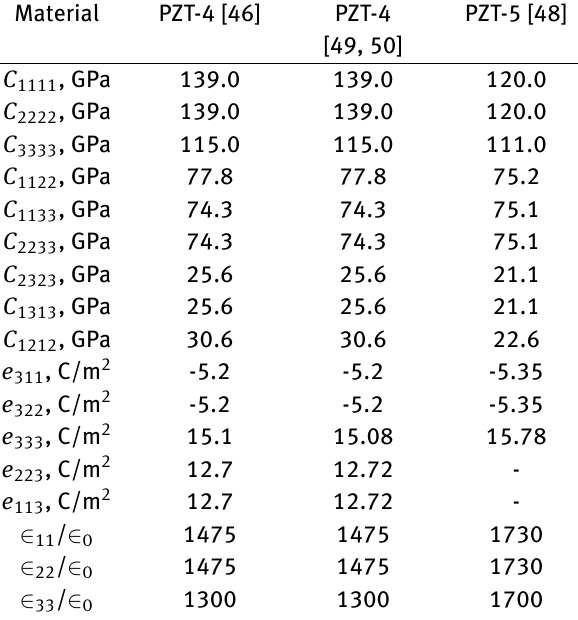
Table 1: Elastic, piezoelectric and dielectric properties of materials 1 . Material